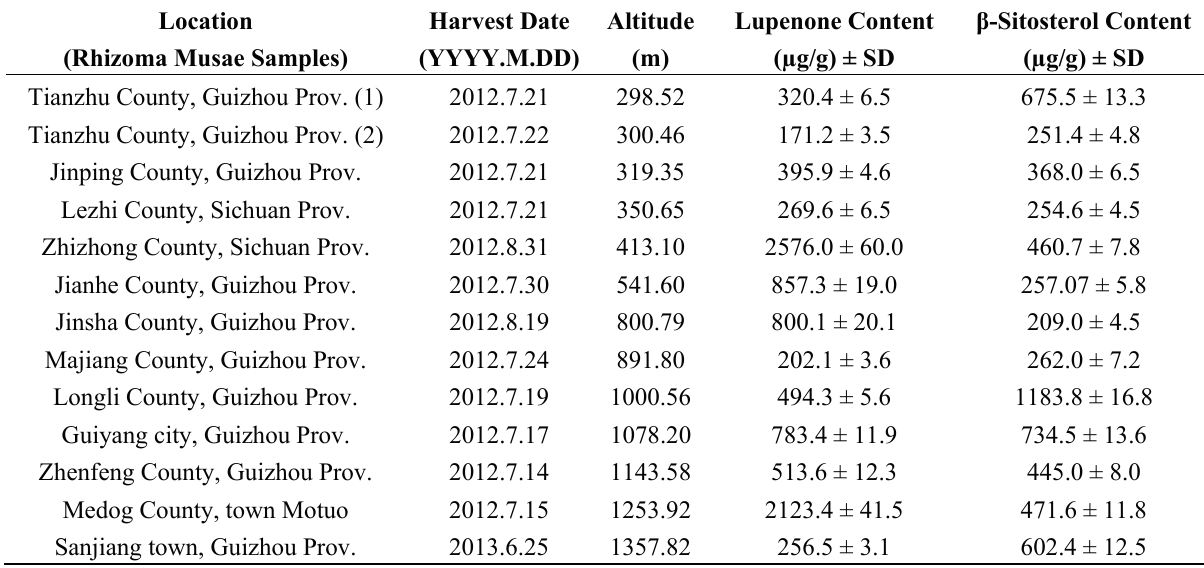
Table 4. Levels of lupenone and β -sitosterol in Rhizoma Musae samples from different